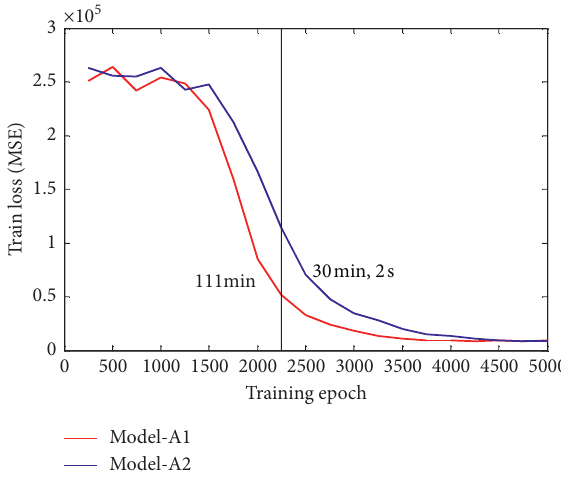
Figure 8: Train loss variation with increased train Table 1: Performance of Model-A2 trained by samples with noisy labels.